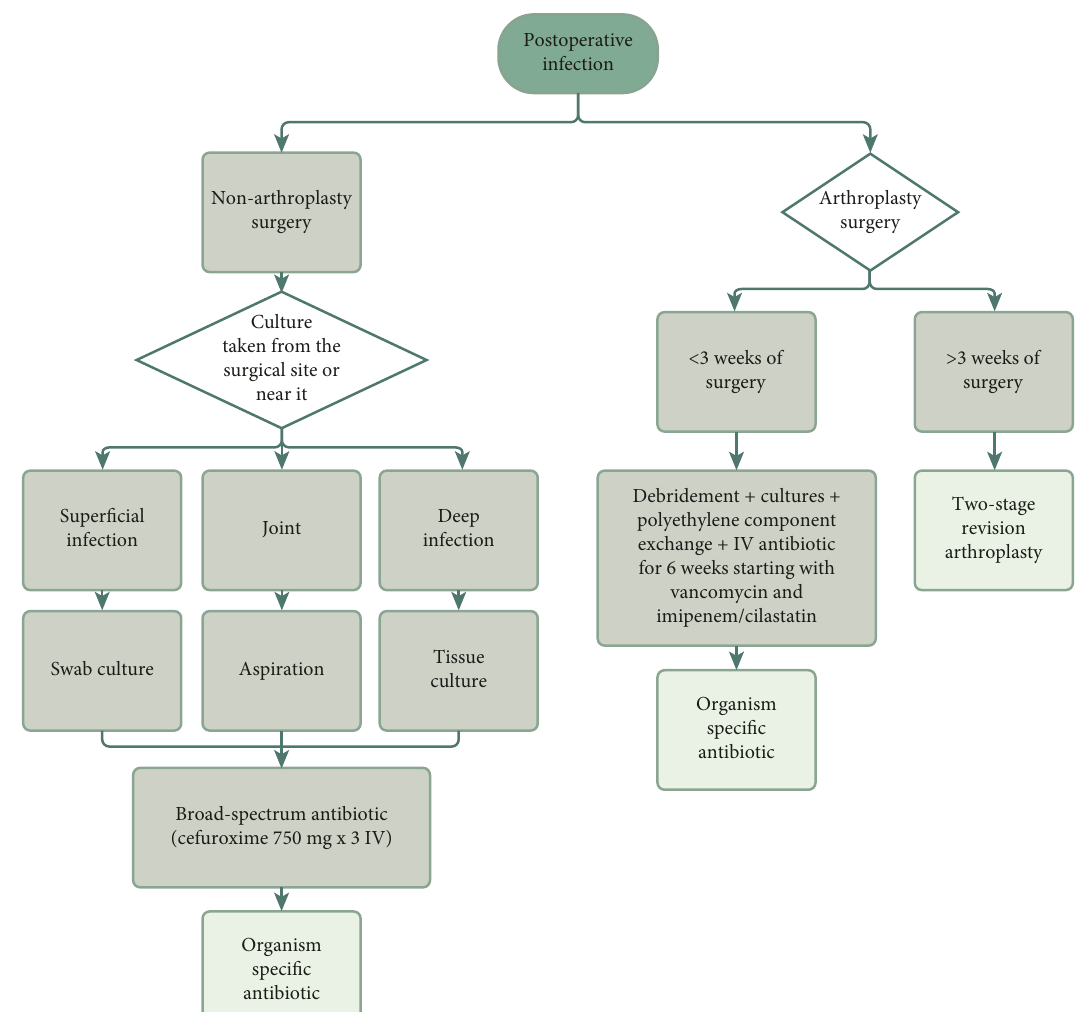
Figure 2: The treatment algorithm used in JUH for patients with postoperative orthopedic